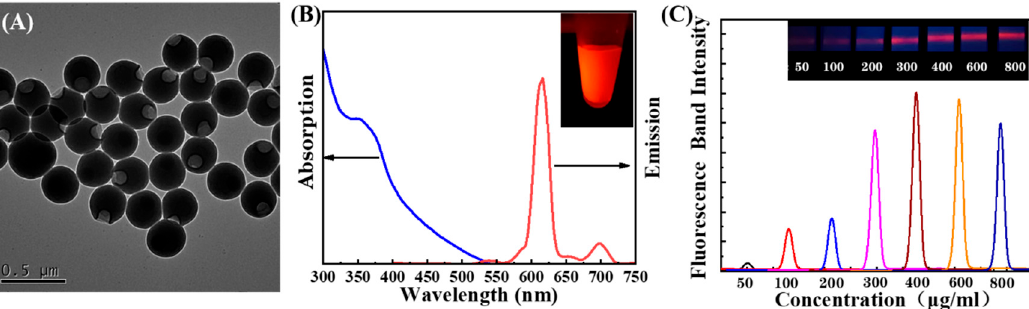
Figure 2. ( A ) TEM images of EuPSM. ( B ) Absorption spectrum and emission spectrum of EuPSM. ( C ) Estimation of probe saturation concentration on EuPSM. ( C ) Estimation of probe saturation concentration on